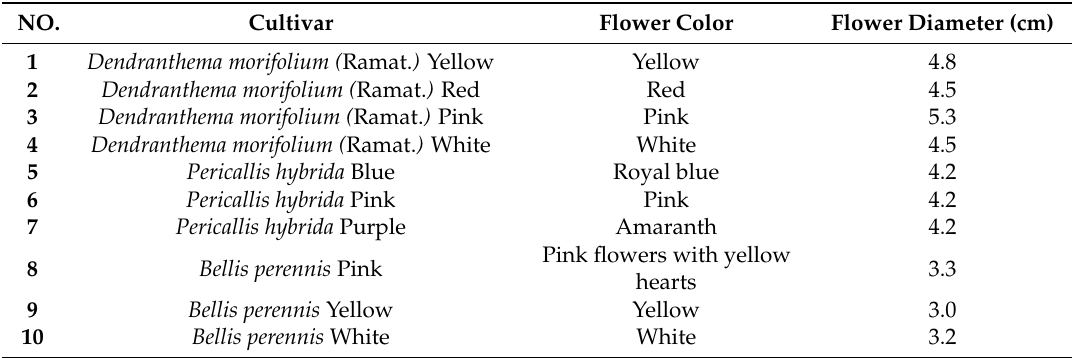
Table 3. Dendranthema morifolium (Ramat.), Pericallis hybrida , and Bellis perennis with different colored